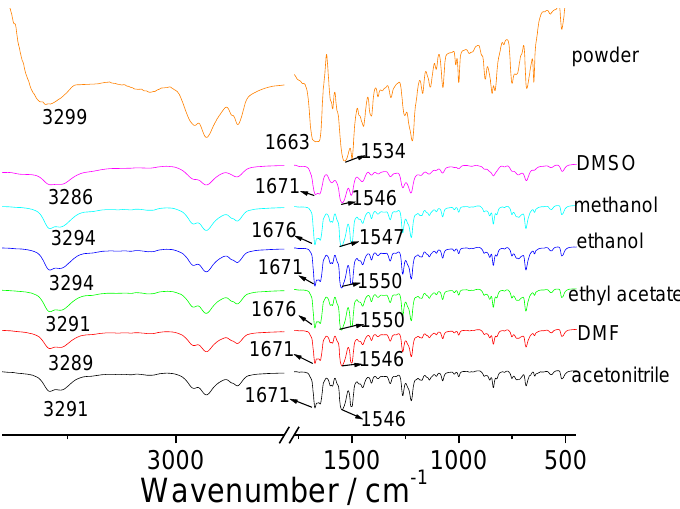
Figure 4. Fluorescence emission spectra of 1 in solution and gel state with different solvents. The concentration of solution was 10 − 5 M and CGC. ( a ) Ethyl acetate; ( b ) acetonitrile; ( c ) ethanol; ( d ) DMSO/H 2 O (4/1, v / v ); ( e ) DMF/H 2 O (4/1, v / v ); ( f ) methanol.